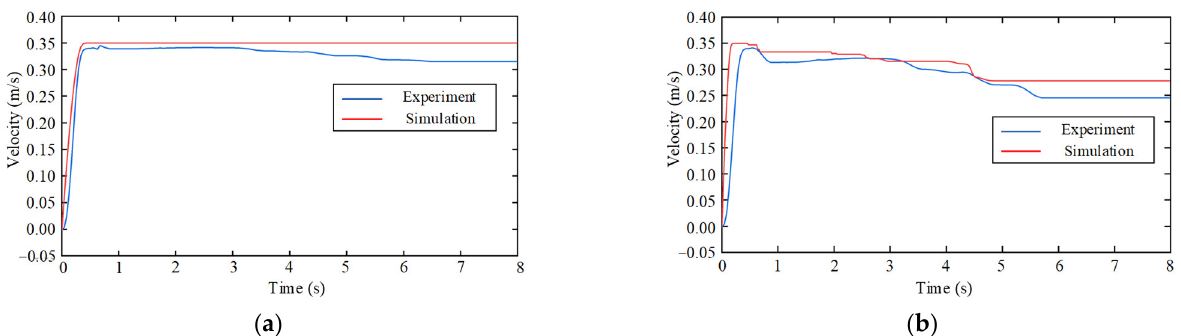
Figure 20. Separation velocity: ( a ) Normal spring; ( b ) Springs under a 10% error condition.